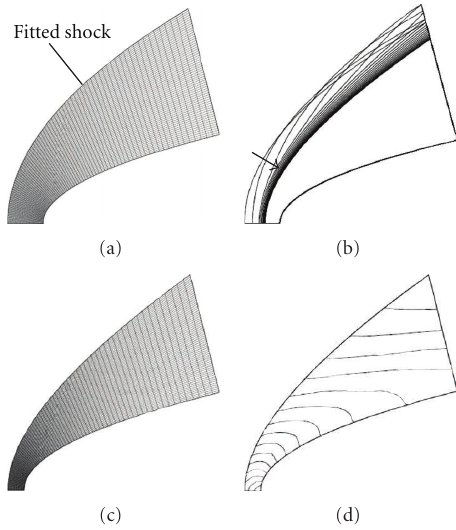
Figure 8: Boundary shock-fitting: (a) initial grid; (b) the grid deforms due to the shock displacement; (c) the fitted shock has settled to its final location; (d) computed flow field.